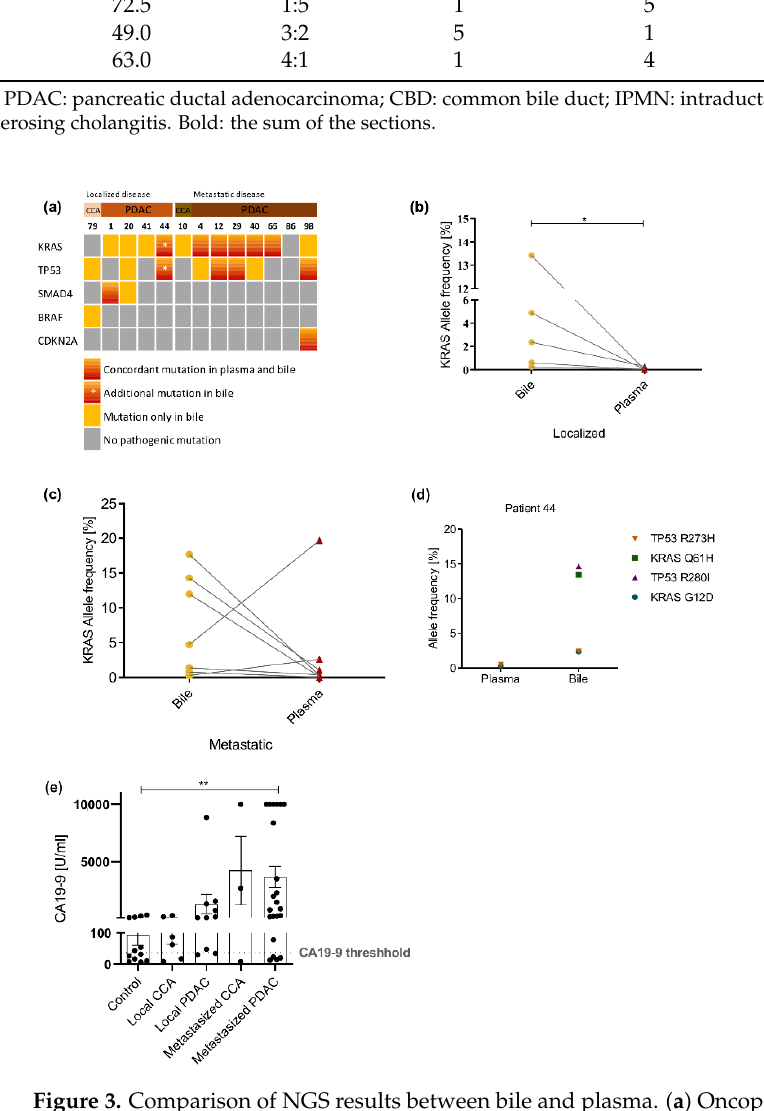
Figure 3. Comparison of NGS results between bile and plasma. ( a ) Oncoprint showing comparison of mutation occurrence in five top genes across all patients in blood and bile cfDNA samples. Patients are divided into controls, patients with localized and patients with metastatic tumors. KRAS allele frequency in bile and plasma cfDNA in patients with localized ( b ) and metastatic disease ( c ). ( d ) KRAS and TP53 allele frequencies of patient 44 in plasma and bile. ( e ) CA19-9 serum levels of patients within our cohort. *: p < 0.05; **: p <